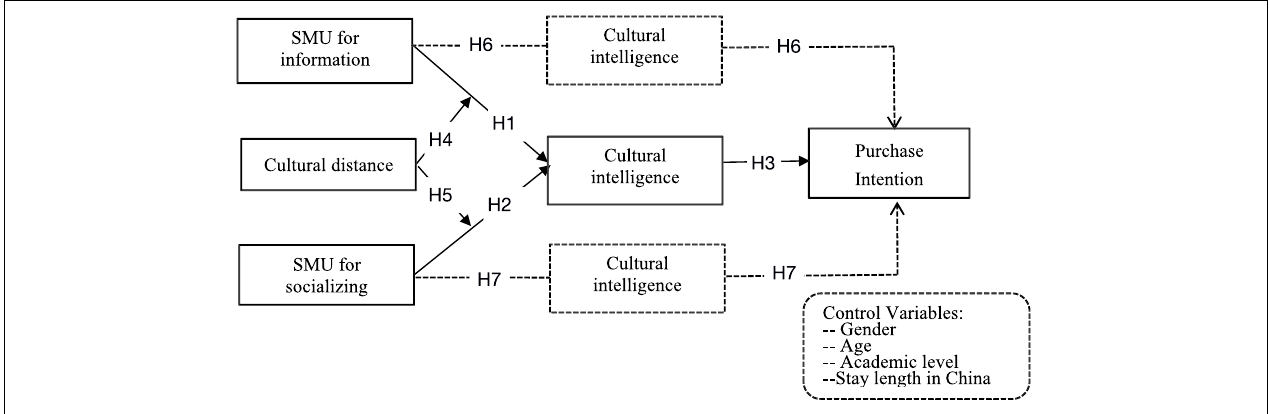
FIGURE 1 | Proposed research model. The dotted line refers to two mediation effects of cultural